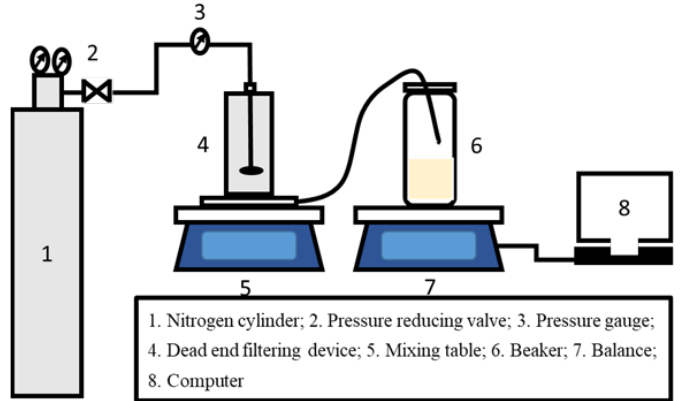
Figure 2. Schematic drawing of the lab-scale dead-end organic solvent nanofiltration (OSN)